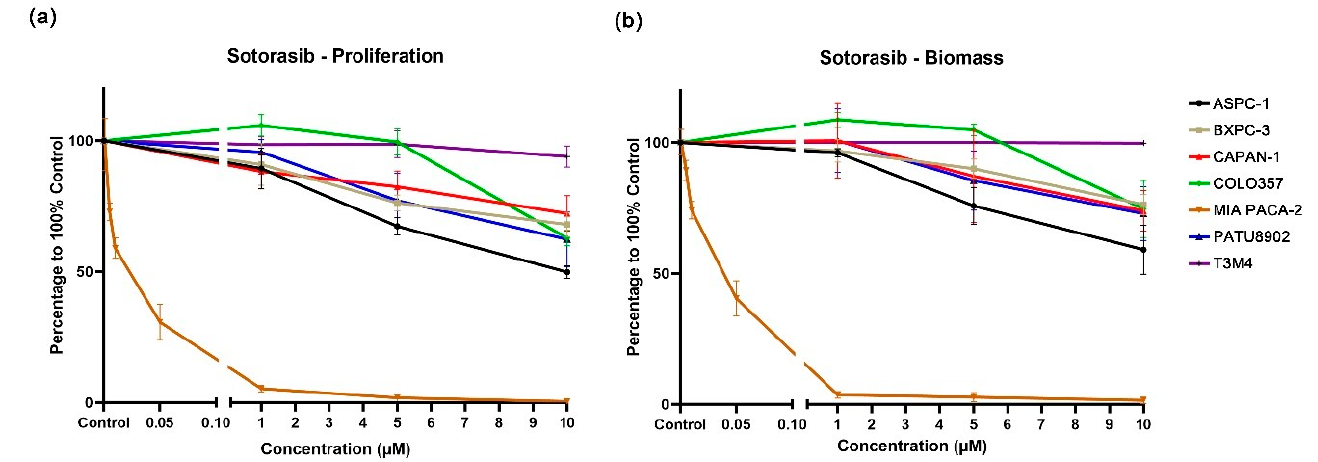
Figure 1. Proliferation ( a ) and biomass ( b ) changes in PDAC cell lines after exposure to different concentrations of sotorasib.